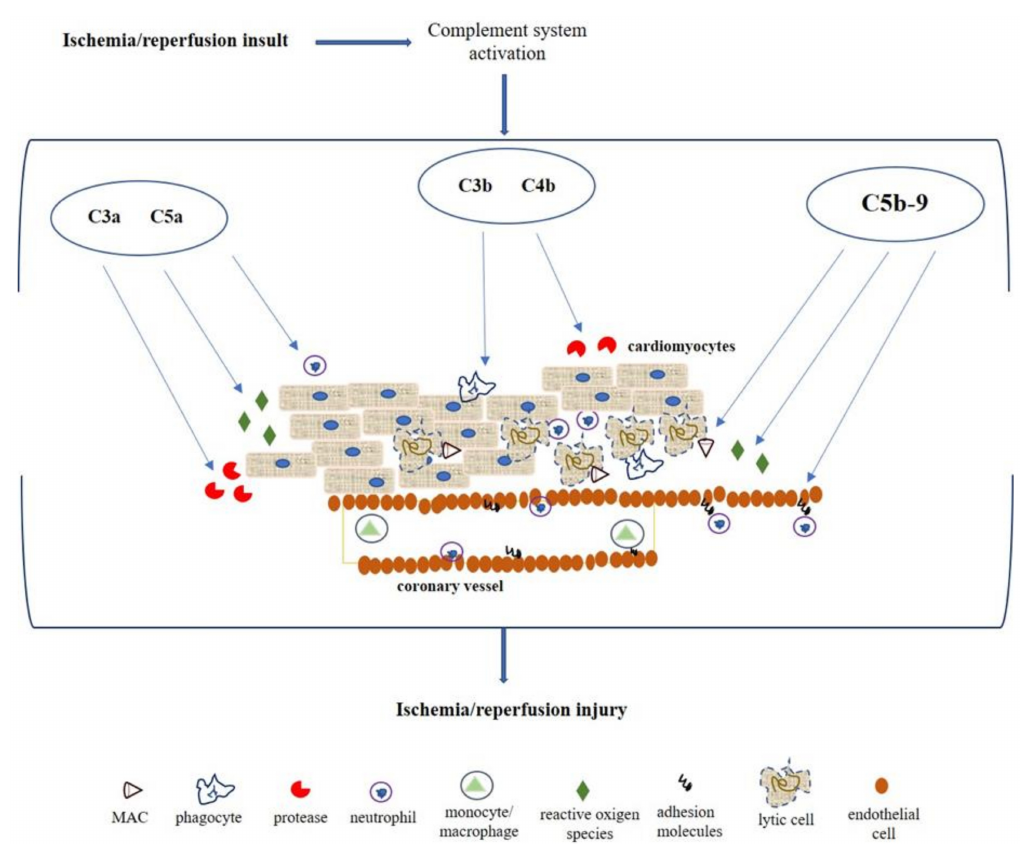
Figure 2. Pathophysiologicalmechanismmediatedbycomplementsystemaftermyocardialischemia / reperfusion insult.